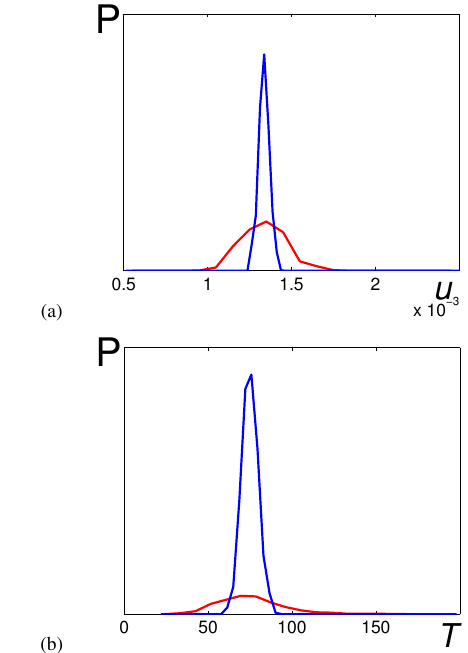
Figure 9. Influence of Q -noise for δ = 0 . 5 (blue), and δ = 2 (red): (a) probability density functions of u coordinates (ms − 1 ), (b) probability density functions of the period T (s).